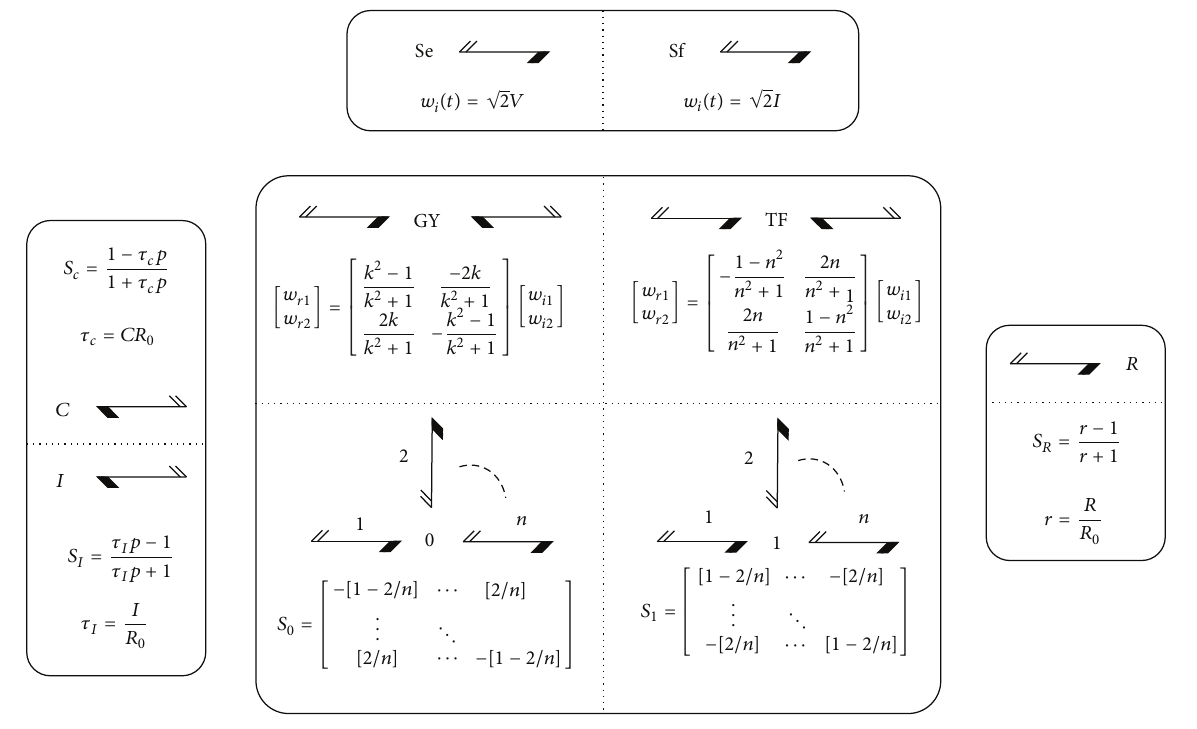
Figure 3: Scattering bond graph relations.